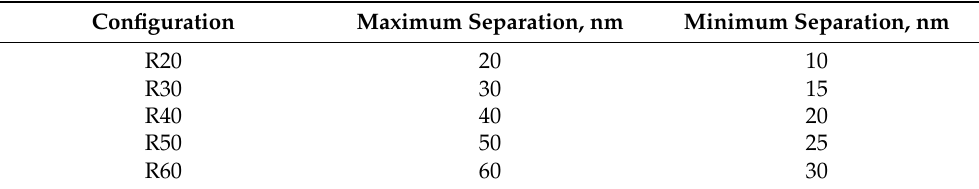
Table 2. Handle separation for cholesterol attachment in the rectangular configuration. The maximum separation is along the long edge of the rectangular configuration while the minimum separation is along the short